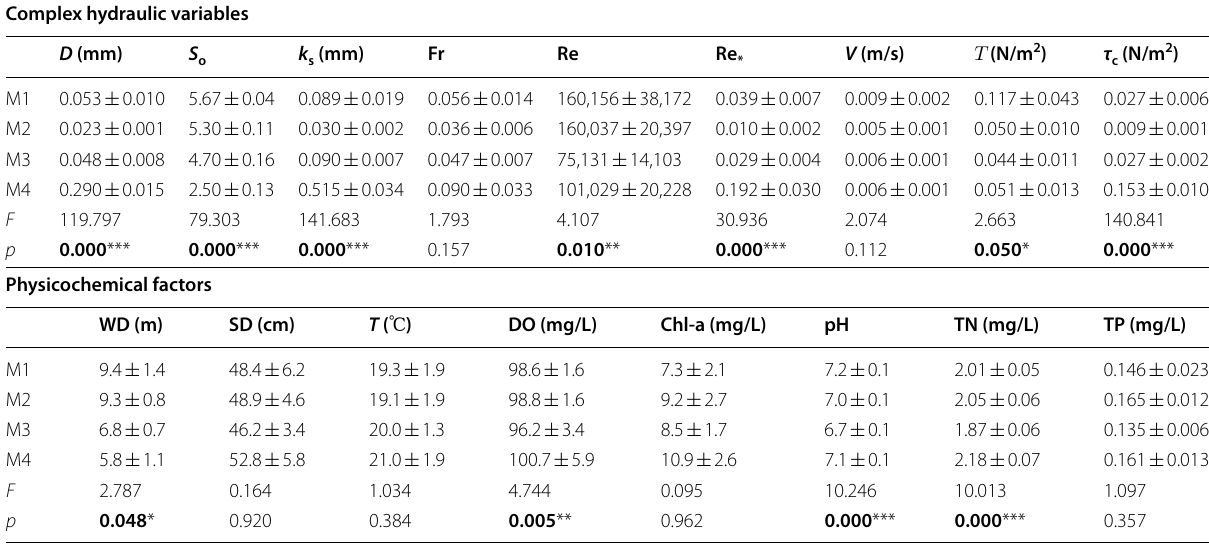
Table 2 Mean value and the one-way analysis of variance (ANOVA) of complex hydraulic variables and physicochemical factors in four habitats, Poyang Lake